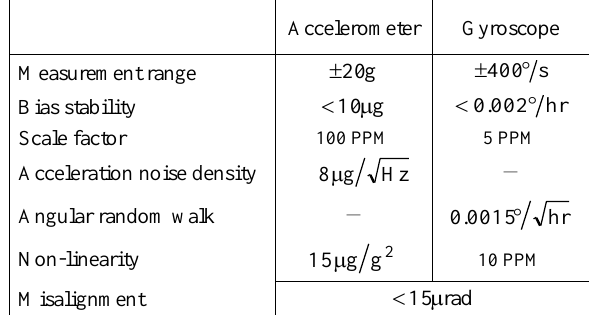
Table 2. The performance characteristics of